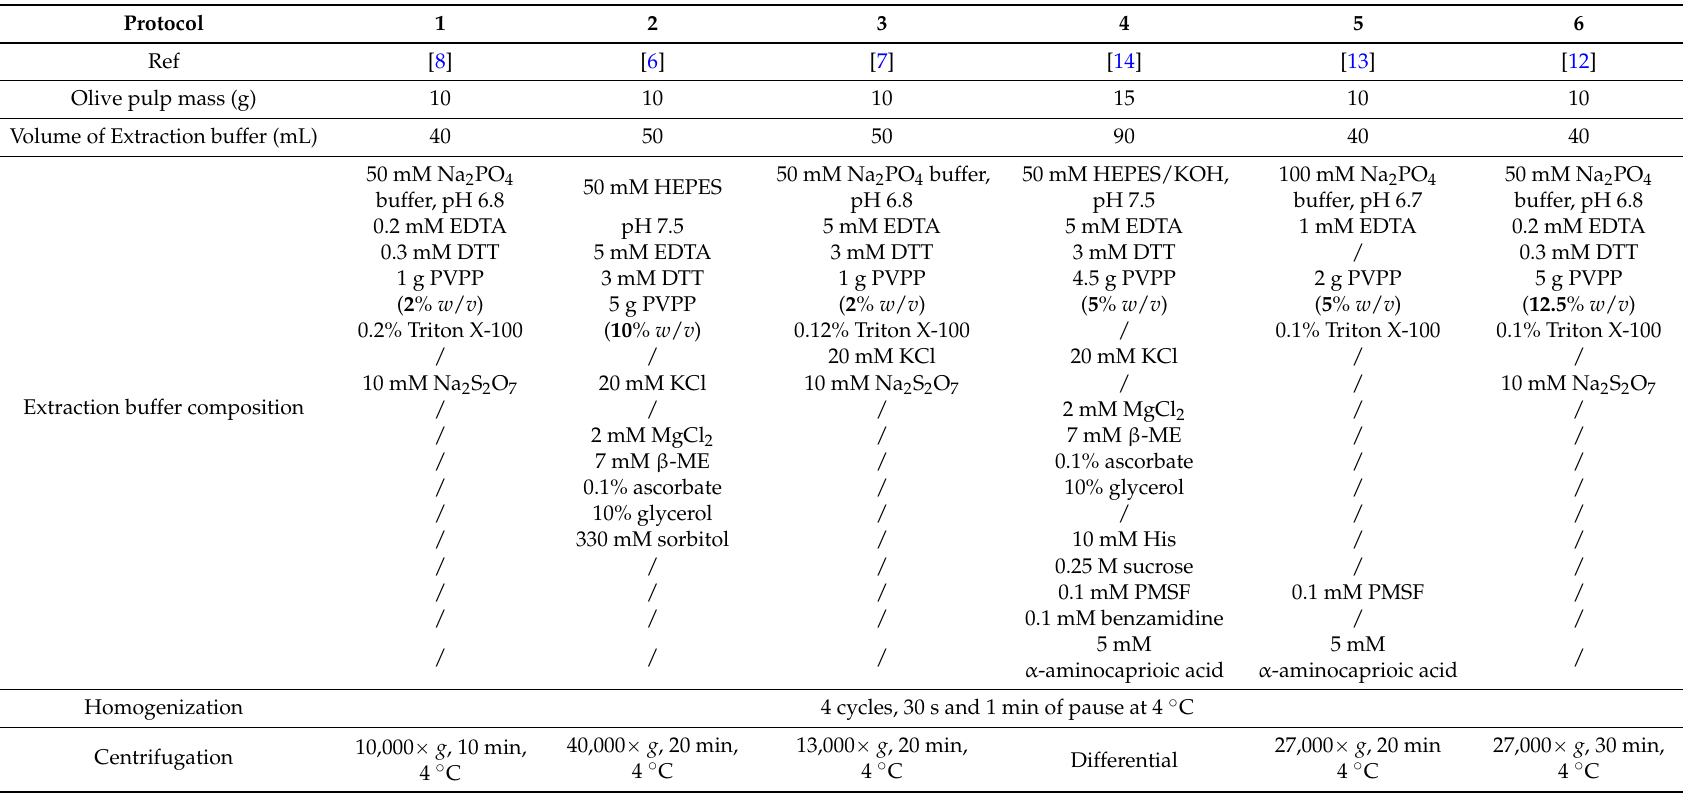
Table 4. Description of protein extraction